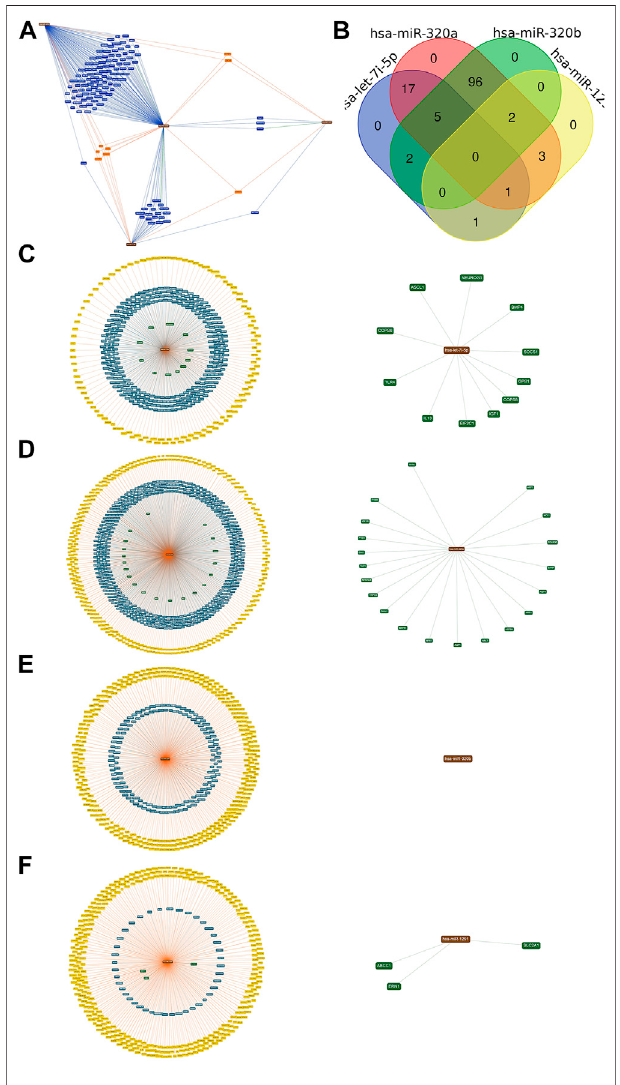
FIGURE 5 | The target and predicted genes of the upregulated miRNAs in APTE samples (A) The bioinformatics tool miRTargetLink Human executed the network. (B) The Draw Venn Diagram online tool generated the Venn diagram. (C) The central node represents the hsa-let-7i-5p . (D) the hsa- mir-320a . (E) the hsa-mir-320b ; and (F) the hsa-mir-1291 surrounded by the validated target with predicted targets in yellow, weak (blue), and strong (green) evidence, which was highlighted in